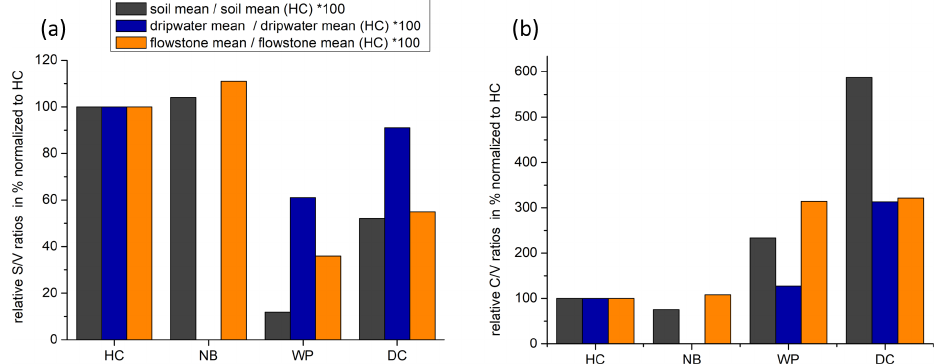
Figure 6. Mean S / V ratios (a) and mean C / V ratios (b) of soil, dripwater and flowstone samples normalized to the respective mean S / V or C / V ratios of